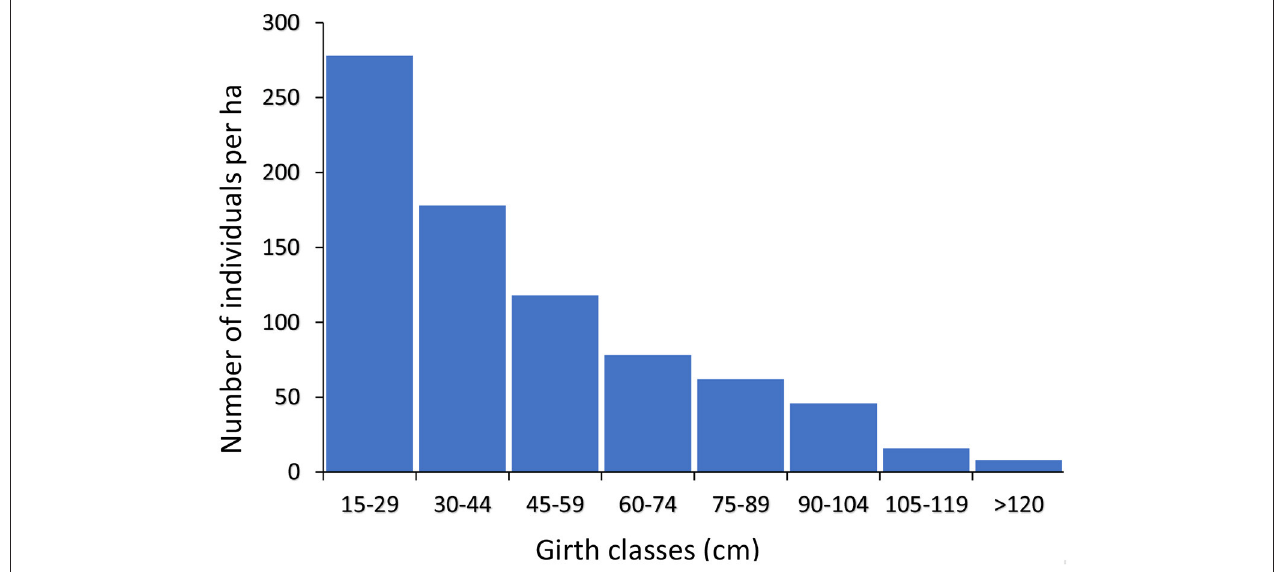
FIGURE 2 | Girth frequency distribution of trees ( ≥ 15cm girth at breast height) in the broad-leaf mixed coniferous forest of Tshothang Chiwog, Bhutan.